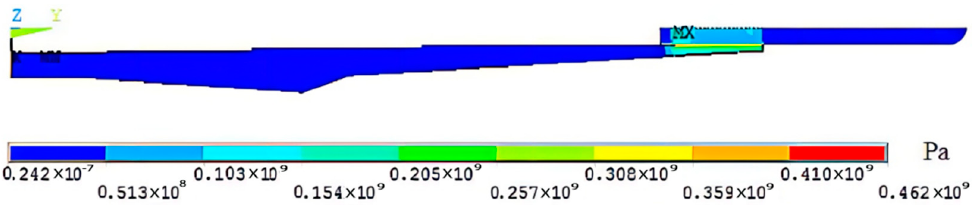
Figure 5. Contact stress distribution diagram.